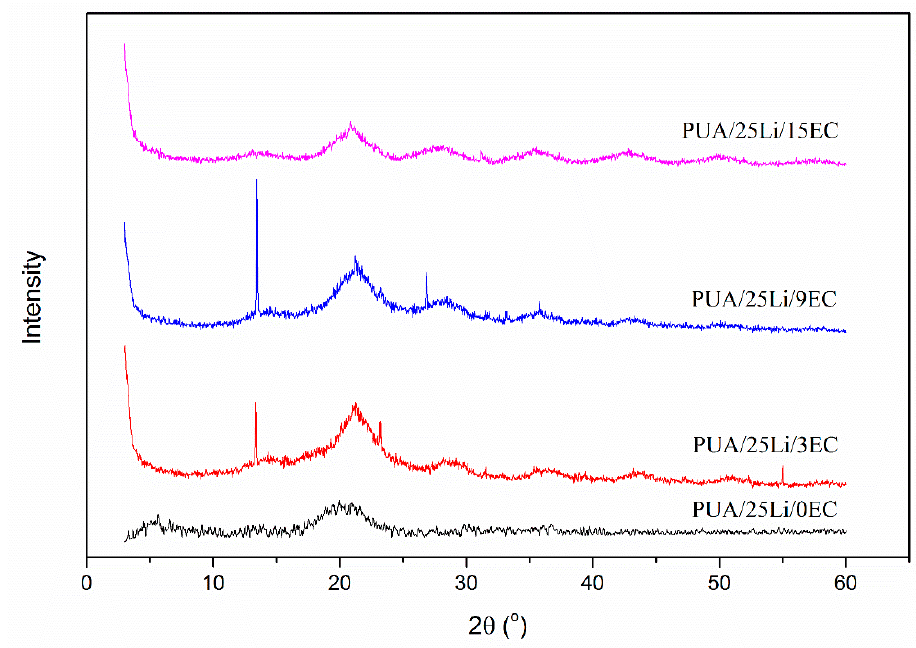
Figure 12. XRD pattern of PUA/LiClO 4 electrolyte at different EC concentrations.